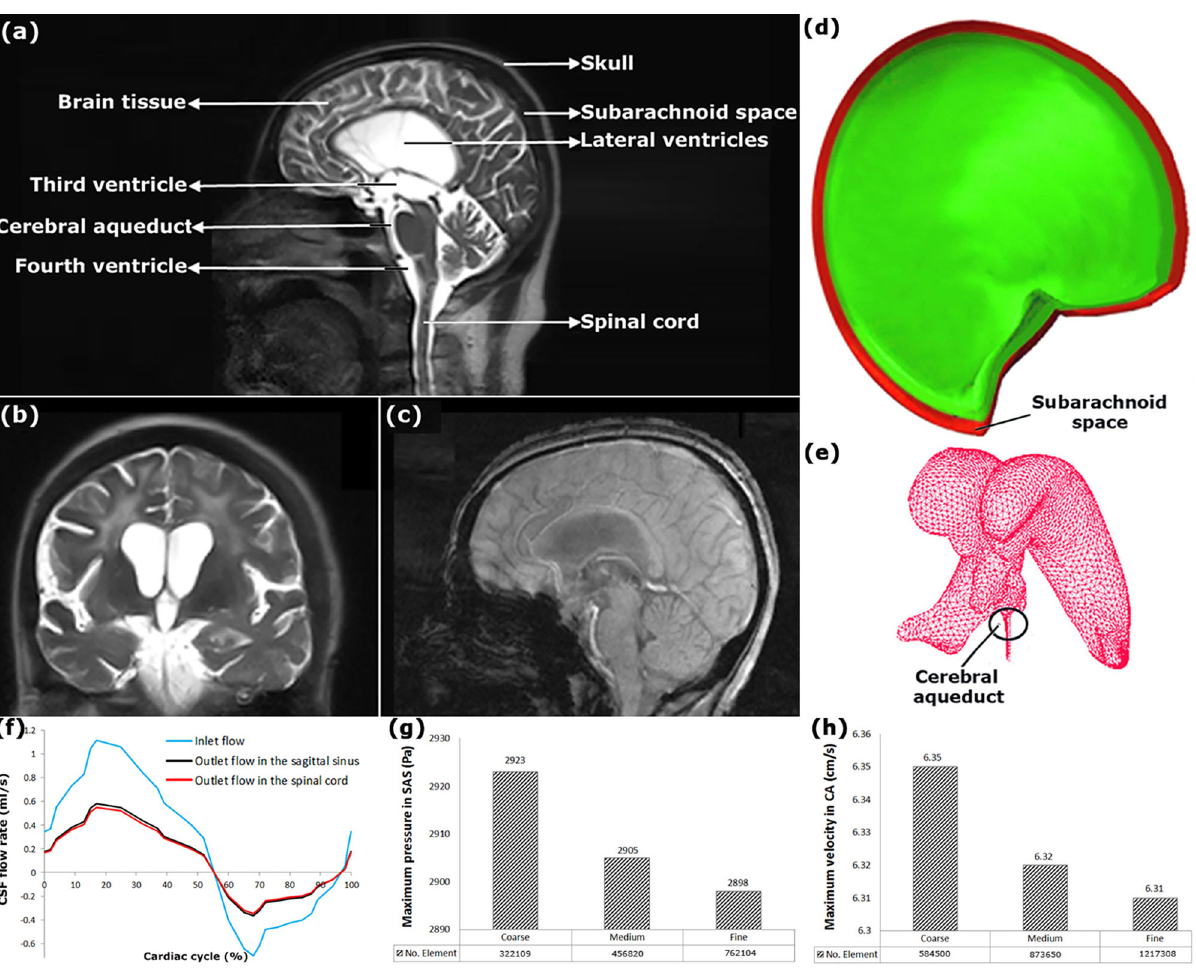
Fig. 4 3D geometrical models, boundary conditions, and mesh convergence study data. a shows the locations of the head substructures. b , c show the head MRI images for patient No. 7. d shows the 3D geometrical model of SAS for patient No. 7. e shows mesh modeling of the ventricular system. f shows the inlet and outlet fl ow-rate diagrams in BC “ C ” . g , h show mesh convergence study for the maximum CSF pressure in SAS and the maximum CSF velocity in CA under the BC “ B ” of the patient No. 7, respectively. BC boundary condition, CSF cerebrospinal fl uid, CA cerebral aqueduct, SAS subarachnoid